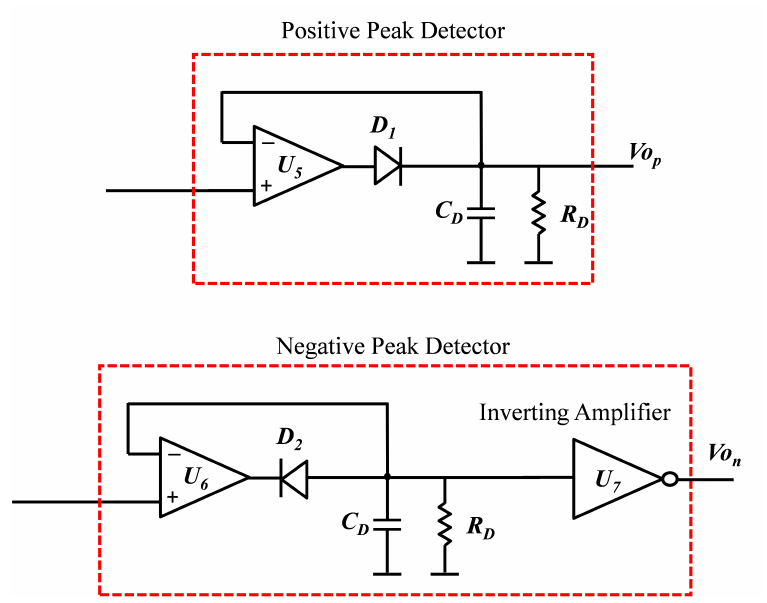
Figure 10. Positive and negative peak detector circuits.